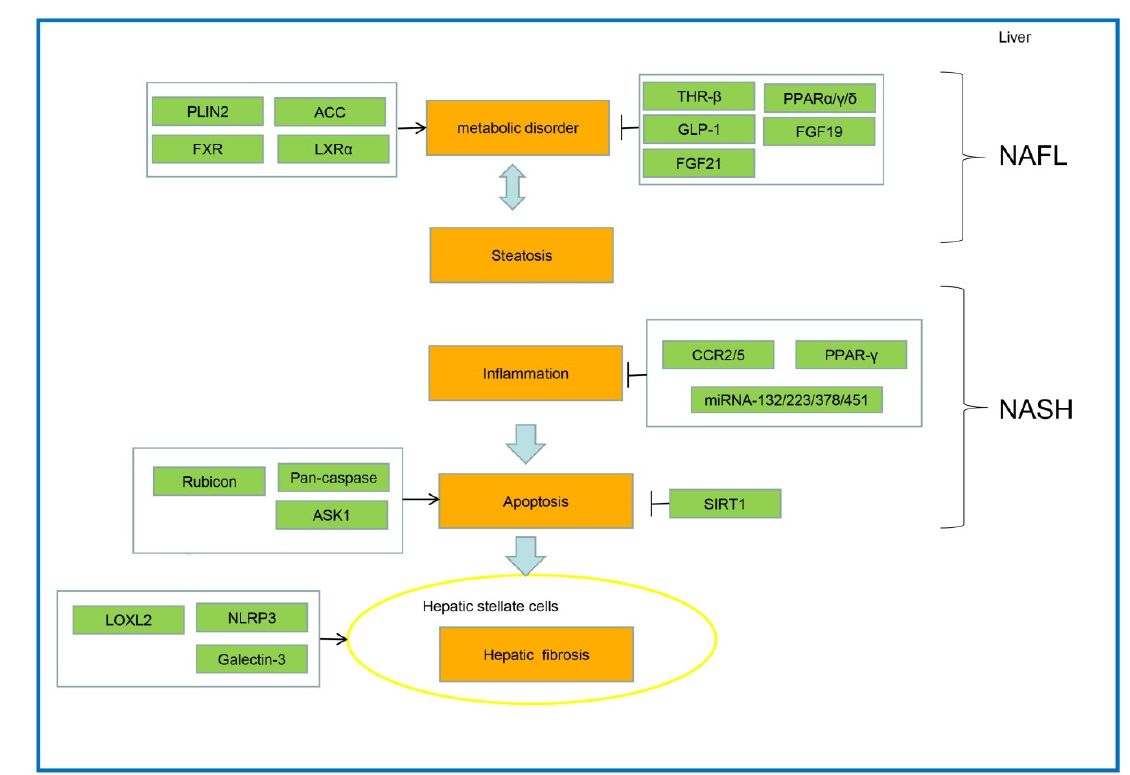
Figure 3. The pathogenesis and key therapeutic targets for